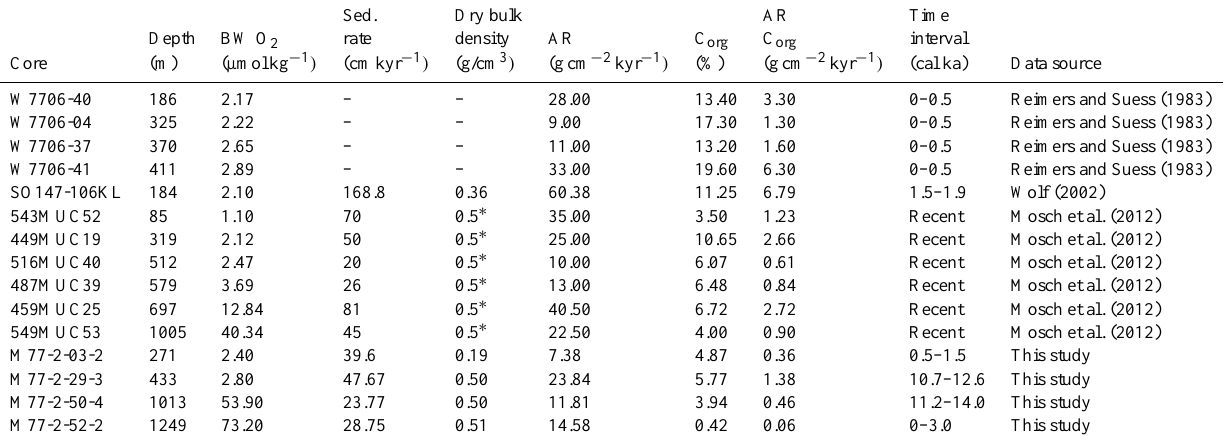
Table A2. Bottom-water oxygen and organic carbon accumulation rates of Quaternary sediment cores from the Peruvian OMZ. BW: bottom water; AR: accumulation rate; ∗ average dry bulk density for near-surface sediments at the 12 ◦ S transect off Peru; –: value not reported.